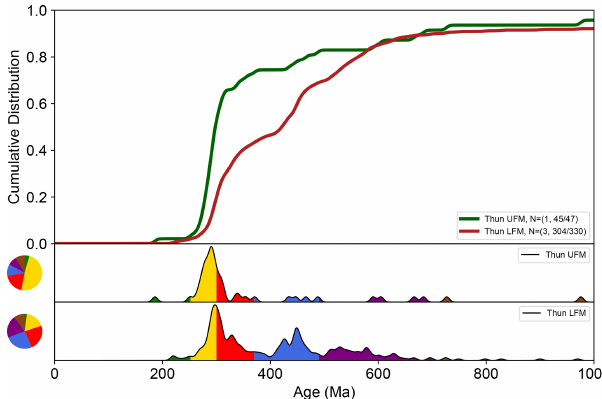
Figure 5. Detrital zircon U–Pb age data from the Thun Section (lo- cations of samples depicted in Fig. 3b). See Fig. 4 legend and cap- tion for additional information.